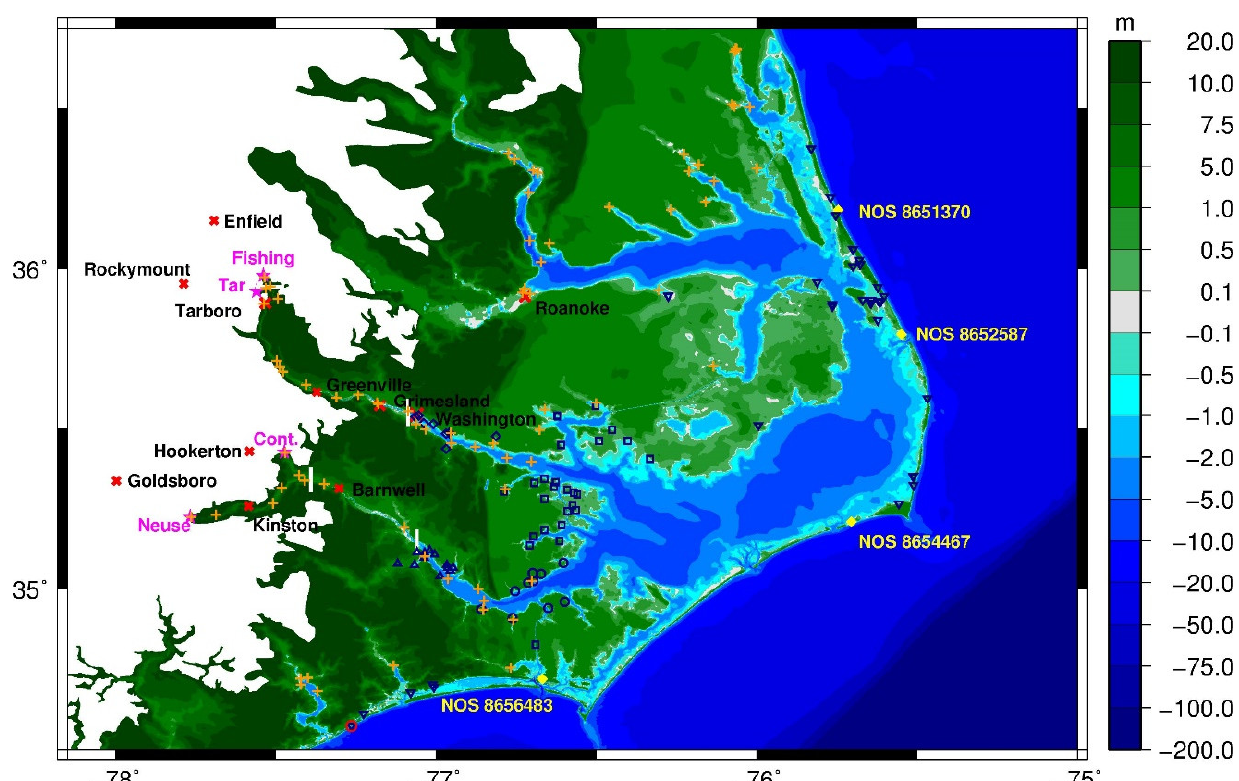
Figure 6. Bathymetry and topography for the Tar-Neuse-Pamlico study area within North Carolina. Existing connection points for the river flux methodology are shown with magenta stars while the new NWM connection points are shown with orange plus signs. White bars indicate the end of the transects down the main stems (used for model comparison), which begin at the magenta stars. Data available for validation includes: USGS gaging stations (red X, names in black), tidal NOS stations (filled yellow diamonds), and high-water marks categorized by location (navy: squares—Tar/Neuse floodplains, circles—Lower Neuse, triangles—Upper Neuse, diamonds—Upper Tar and inverted triangles—Other). Red circle indicates location of Other HWM that is significantly impacted by the addition of the NWM streamflows.